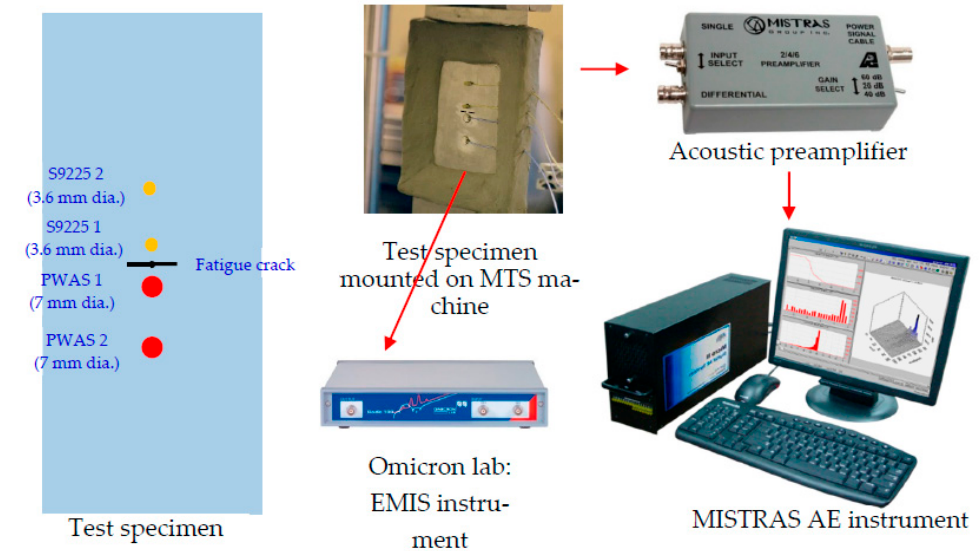
Figure 2. Experimental setup for capturing AE signals during fatigue crack event.